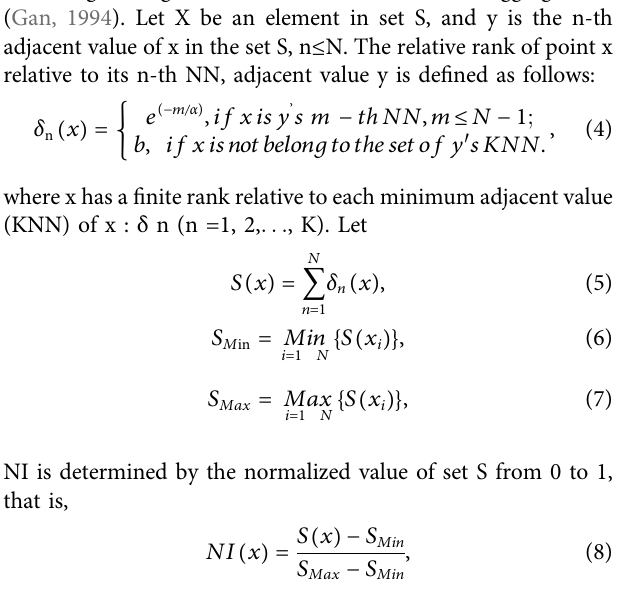
Frontiers in Earth Science |